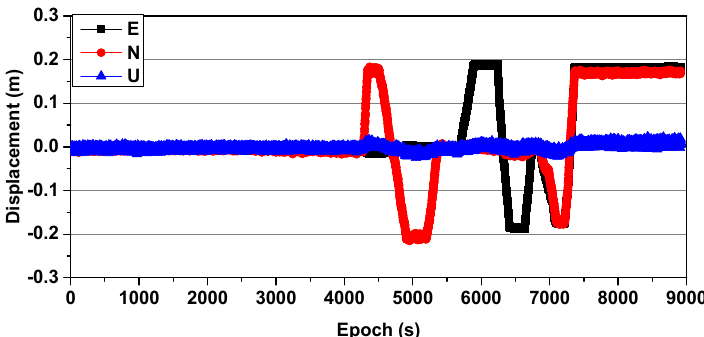
Figure 4. CD02 antenna installed on the moving platform.